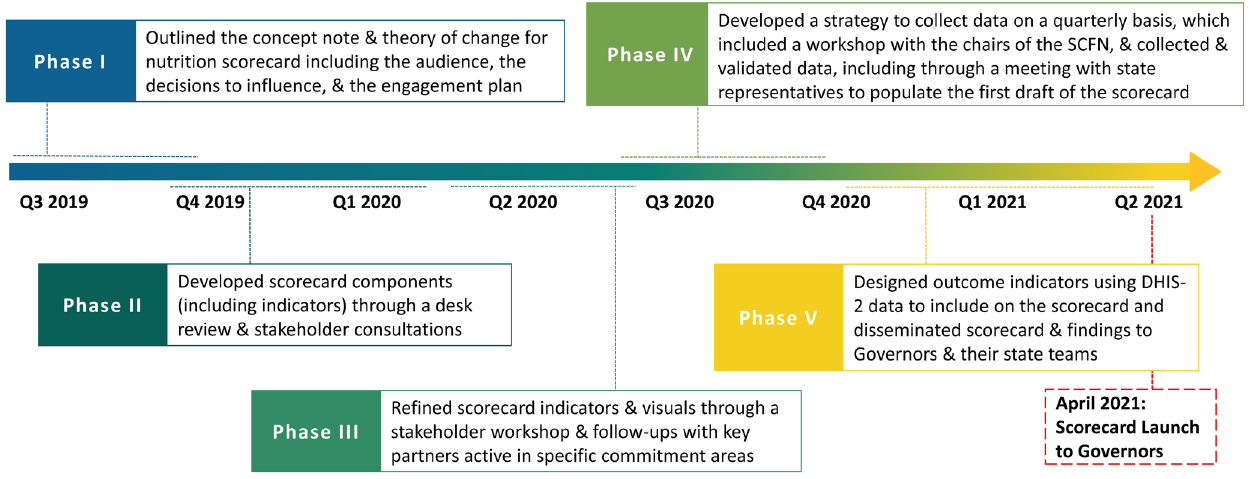
Figure 2. Nutrition Scorecard development process. SCFN=State Committees on Food and Nutrition; DHIS-2=District Health Information System 2.